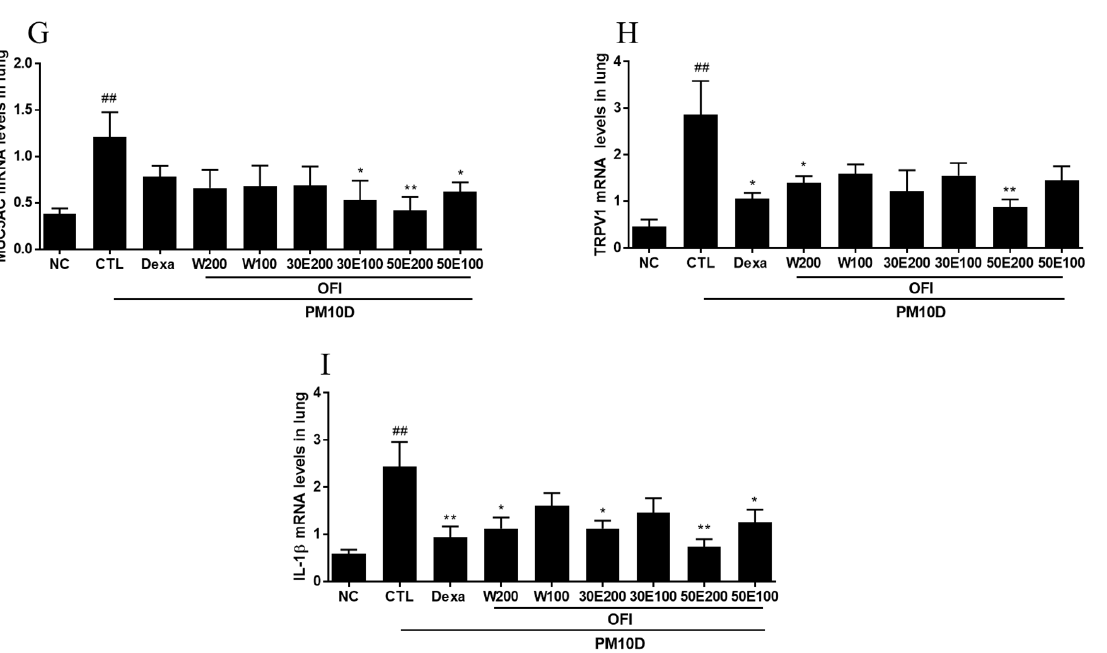
Figure 4. Effects of water and ethanolic extracts of OFI on cytokine gene expression in the lungs of mice with PM10D-induced airway inflammation. ( A ) CXCL-1, ( B ) MIP2, ( C ) cyclooxygenase (COX)-2, ( D ) TNF- α , ( E ) IL-5, ( F ) IL-6, ( G ) mucin 5AC (MUC5AC), ( H ) transient receptor potential cation channel subfamily V member 1 (TRPV1), and ( I ) IL-1 β gene expression in the lungs. NC: BALB/c normal control group; CTL: PM10D-induced control group; Dexa: 3 mg/kg dexamethasone-treated PM10D-induced group; OFI-W 100 and 200: PM10D-induced group treated with 100 and 200 mg/kg OFI-water extract, respectively; OFI-30E 100 and 200: PM10D-induced group treated with 100 and 200 mg/kg OFI-30% ethanol extract, respectively; OFI-50E 100 and 200: PM10D-induced group treated with 100 and 200 mg/kg OFI-50% ethanol extract, respectively. Data are expressed as means ± SEM, n = 8. ## p < 0.01 and ### p < 0.005 vs. NC; * p < 0.05 and ** p < 0.01 vs. CTL.